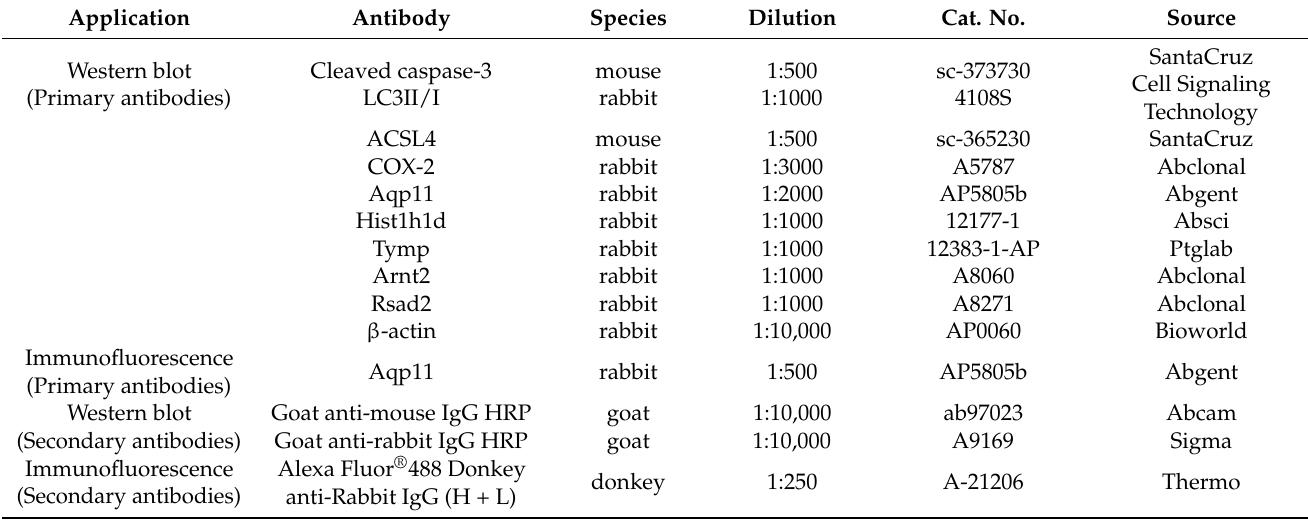
Table 3. Antibodies used in the present